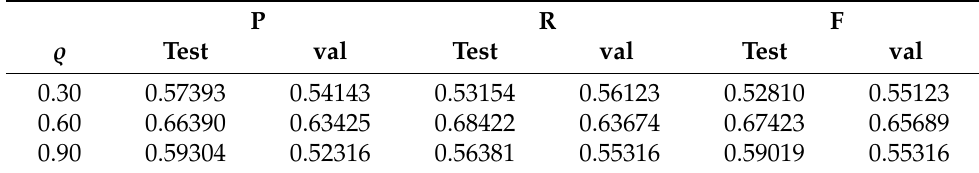
Table 3. The results of the evaluation